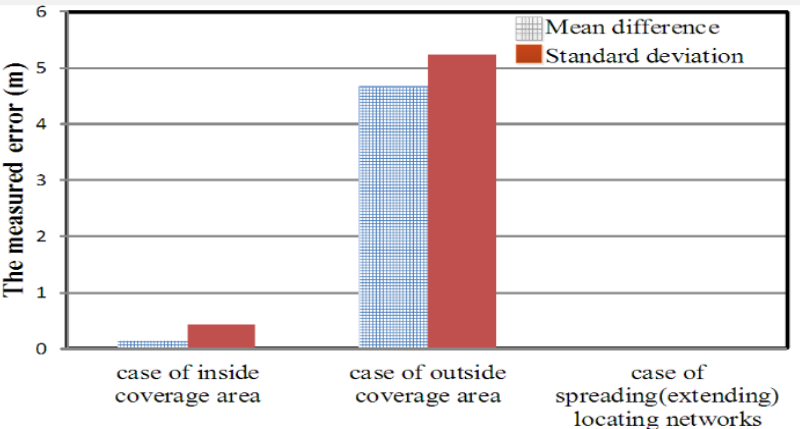
Figure 10. The locating accuracy by using proposed GA in the various scenarios presented in Figure 9.